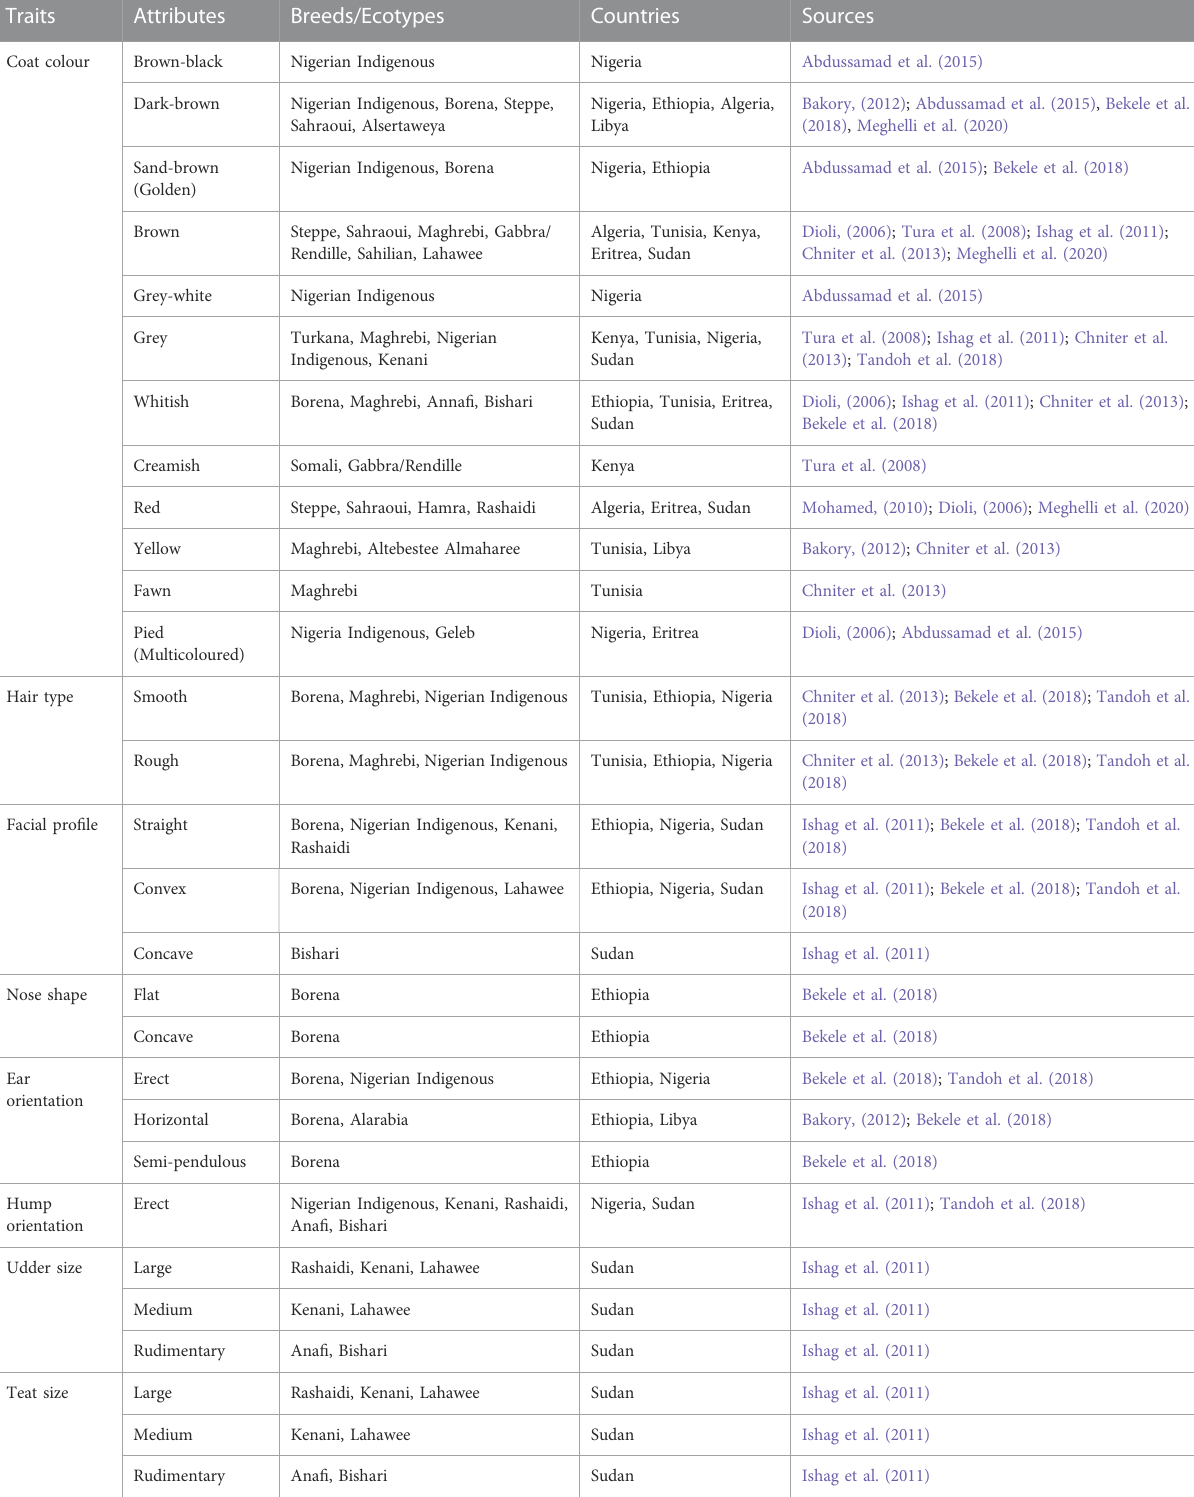
TABLE 1 Physical qualitative traits of camels.